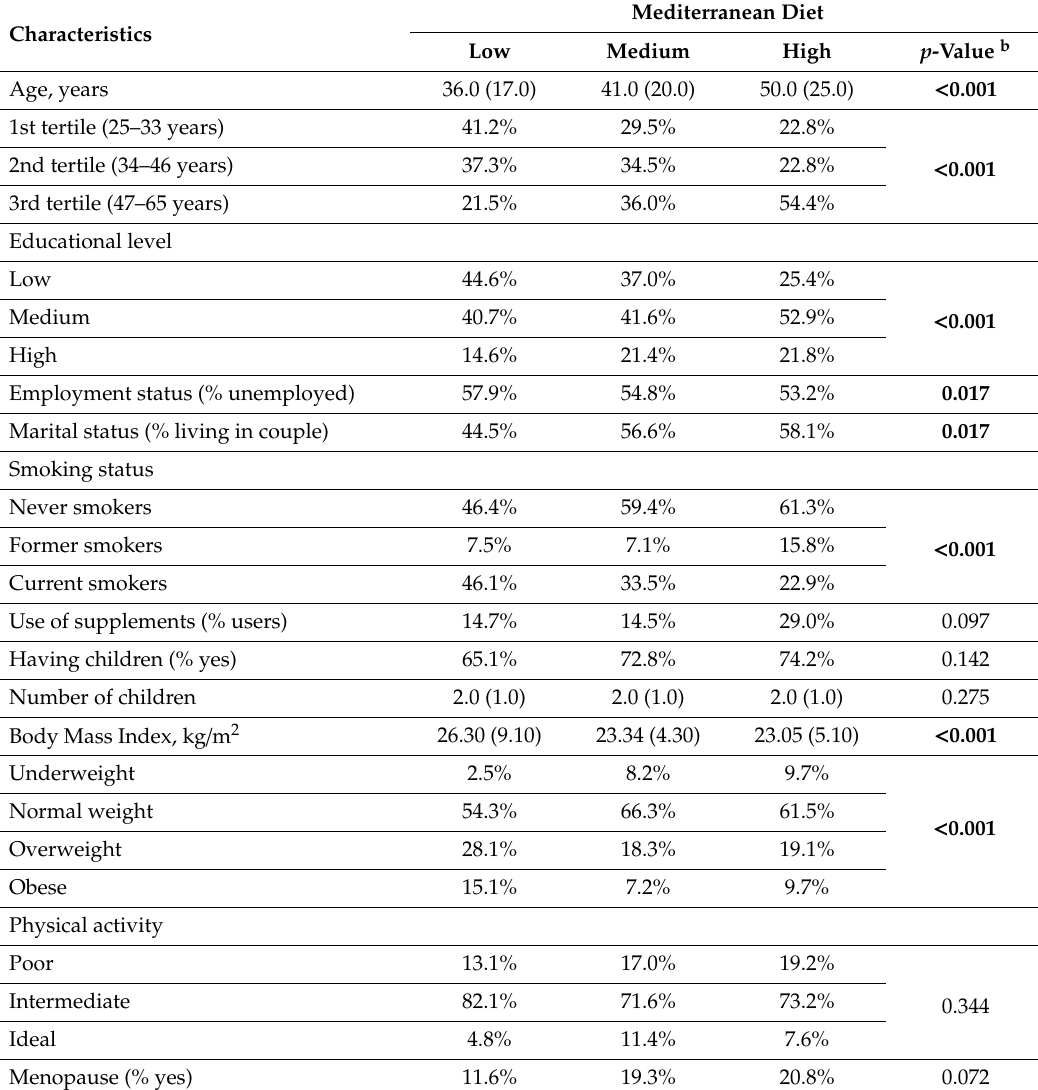
Table 3. Characteristics of women according to adherence to Mediterranean diet a